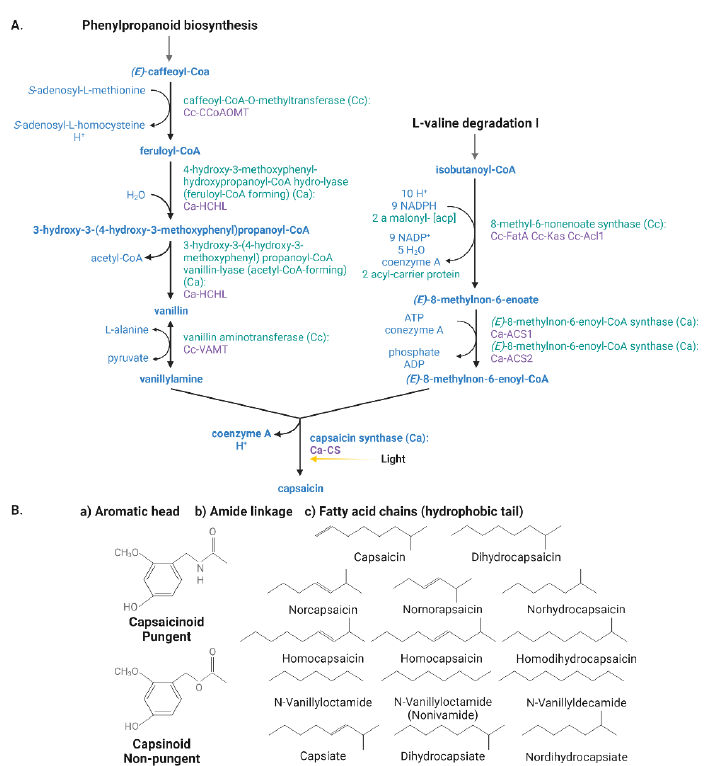
Figure 2. ( A ) Capsaicinoid biosynthetic pathway in peppers ( Capsicum spp.) via phenylpropanoid and L-valine Degradation I. The yellow arrow indicates the light signal that regulates transcription factors at the molecular level. ( B ) Chemical structure of the most abundant capsaicinoids (pungent) and capsinoids (non-pungent) molecules of Capsicum fruits. Capsaicinoids and capsinoids differ in the R group (fatty acids) present.